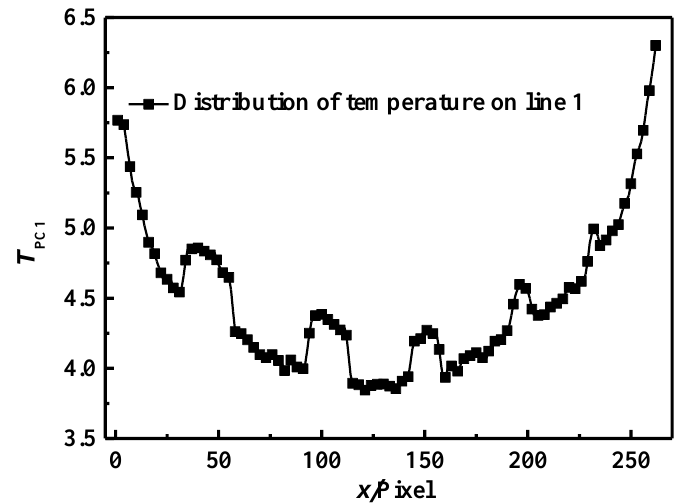
Figure 5. The temperature distribution along line 1 in Figure 4a.